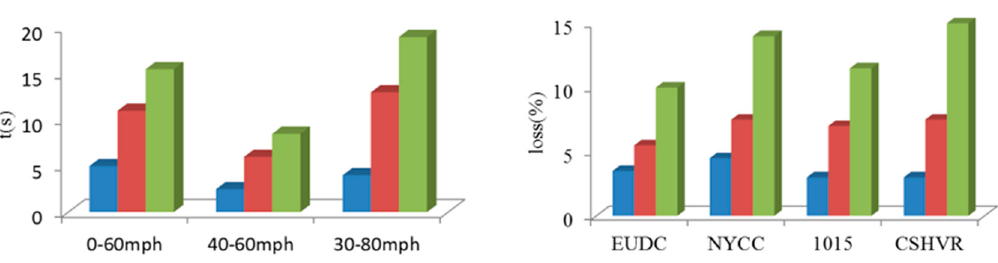
Table 2. Vehicle, Battery and SC Parameters.